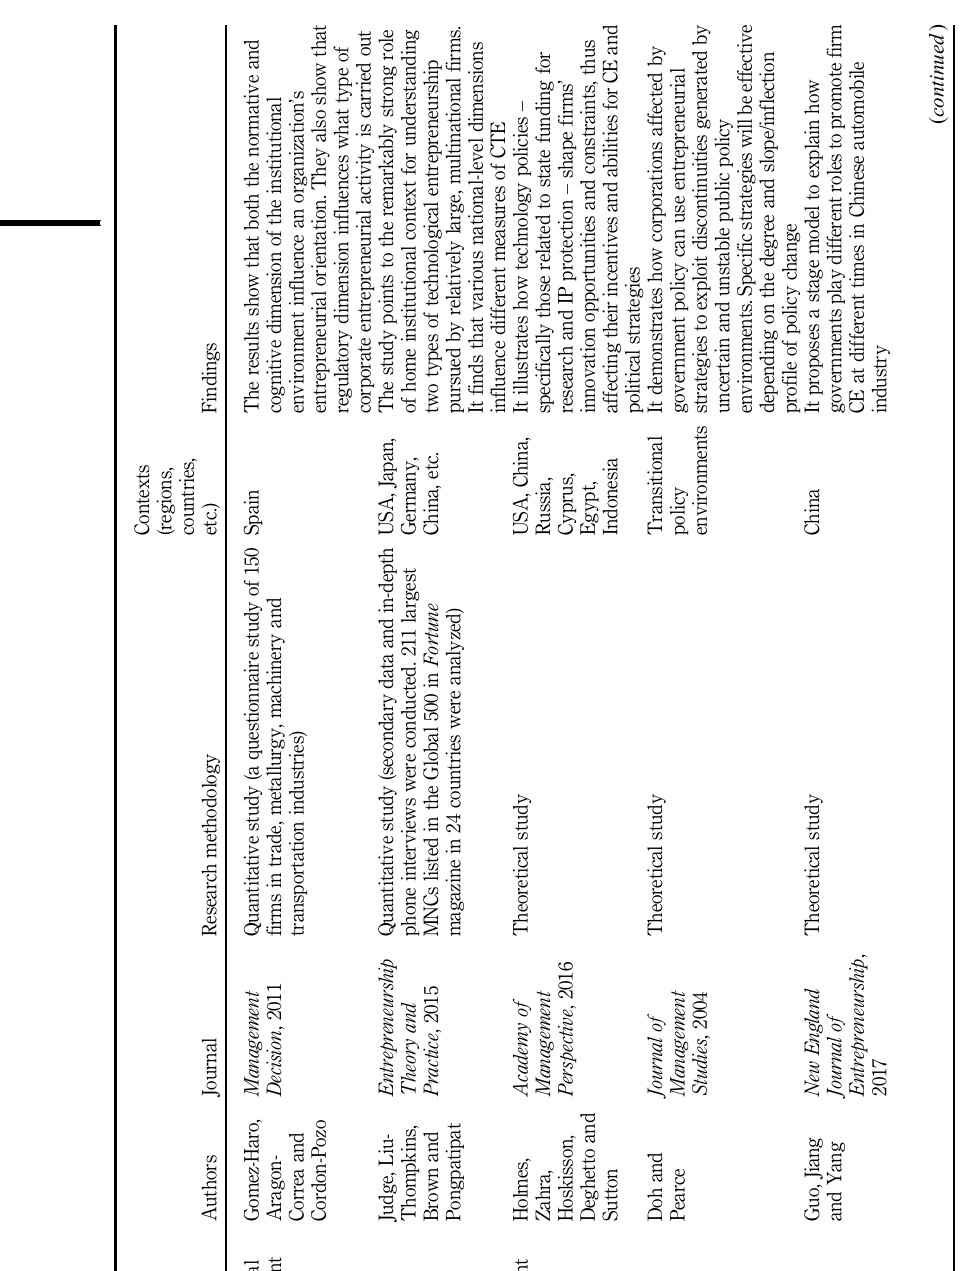
Table I. Selected